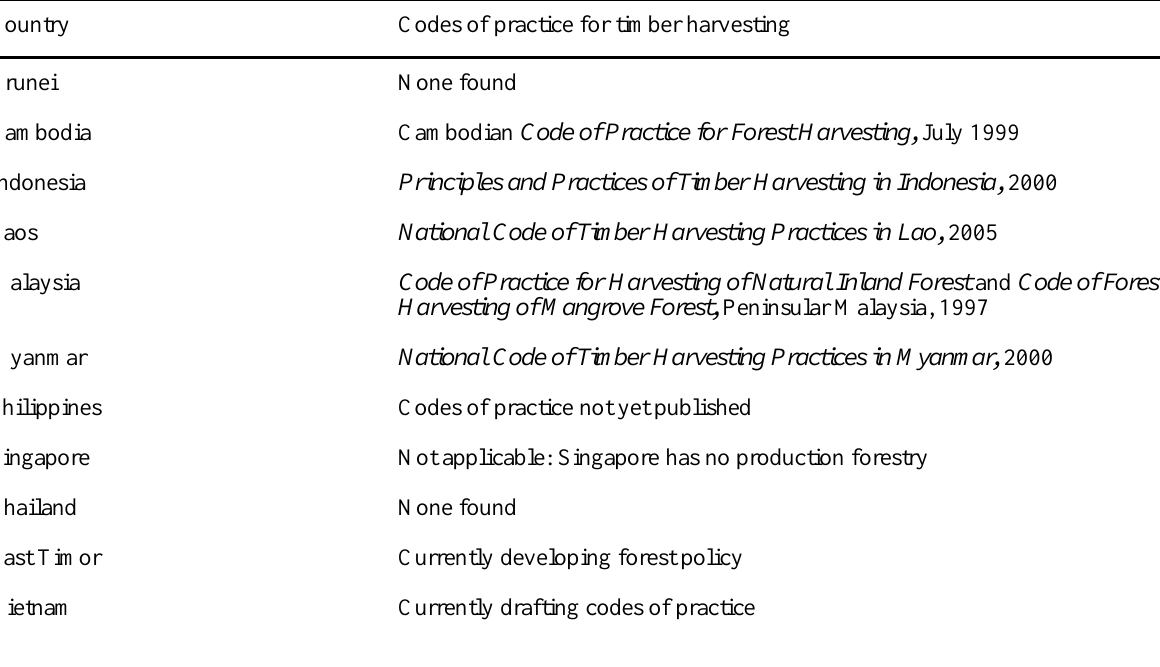
Table 3. Status of codes of practice in Southeast Asian timber producing nations as of 2007.